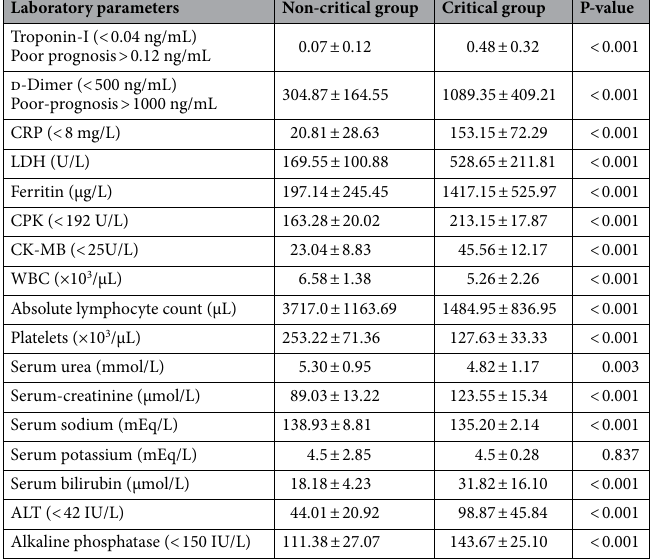
Table 2. Comparison of specific and non-specific cardiac injury markers and laboratory parameters between critical and non-critical